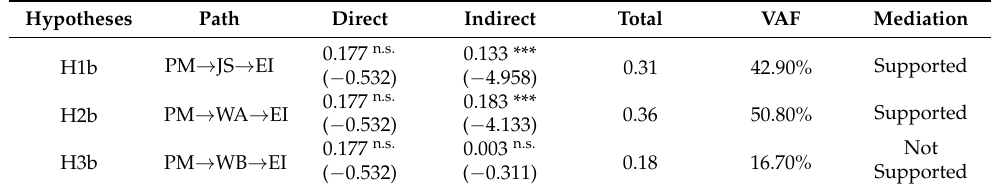
Table 6. Test of mediation